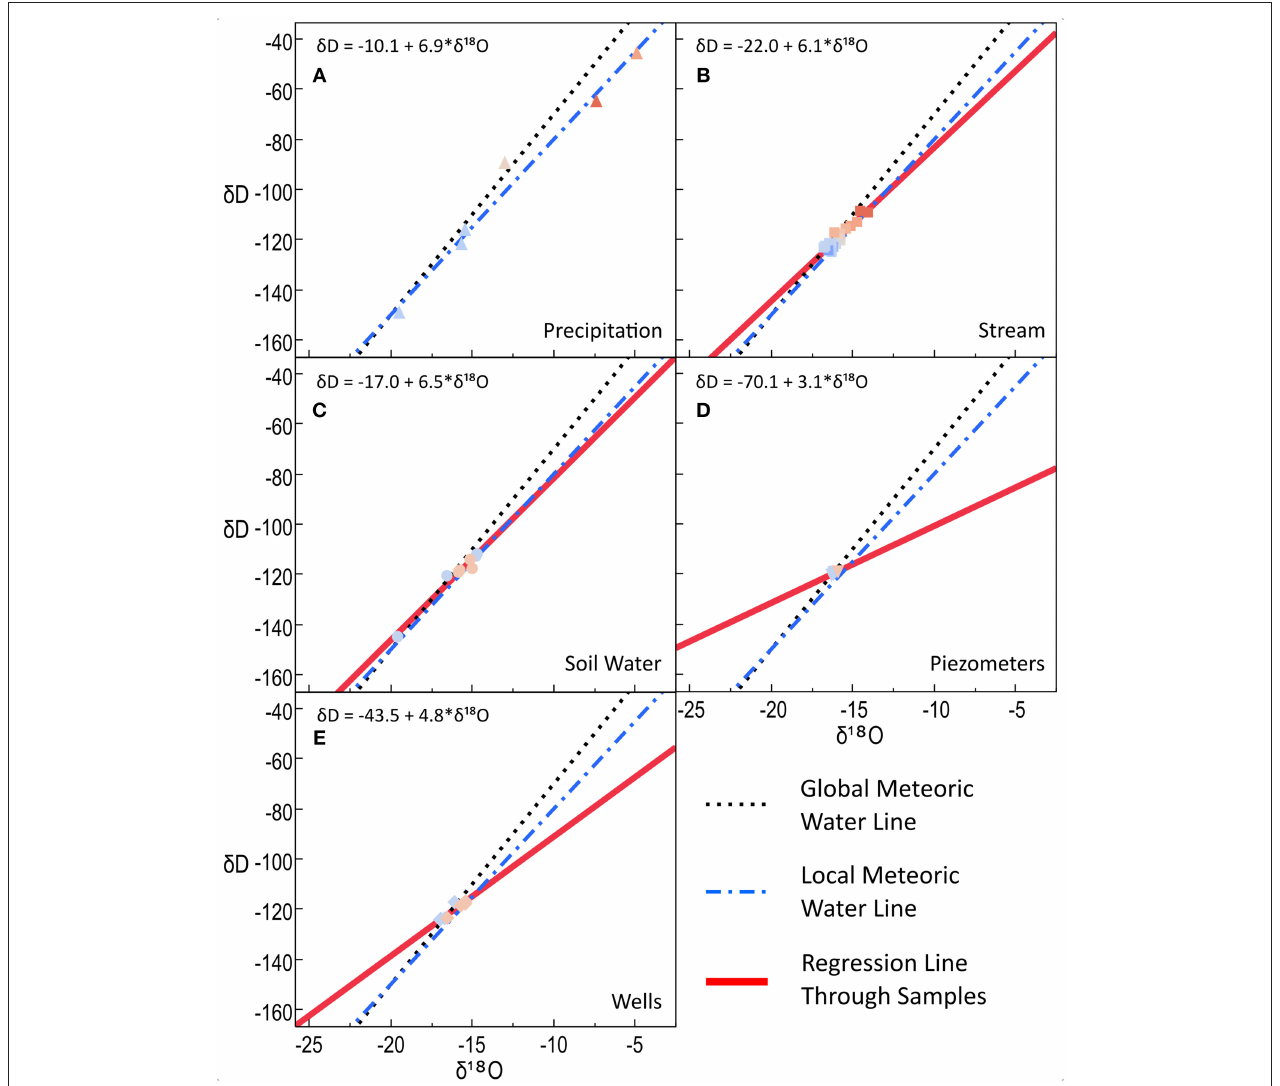
FIGURE 8 | Water isotopes for all waters in RME, by source: (A) precipitation, (B) stream, (C) soil water, (D) saprolite water (piezometers), and (E) groundwater. Points represent samples; point colors progress from blue to red as the sample dates shift from March to July 2017. R 2 adj for all regression lines varies between 0.7 and 0.97; note that for comparison purposes, axis ranges are held constant across all panels although sample variability is damped in subsurface samples relative to precipitation. The local meteoric water line was determined by a regression of the precipitation samples. Regression lines are extended beyond measured points for visual clarity, and regression formulas are included for each group of